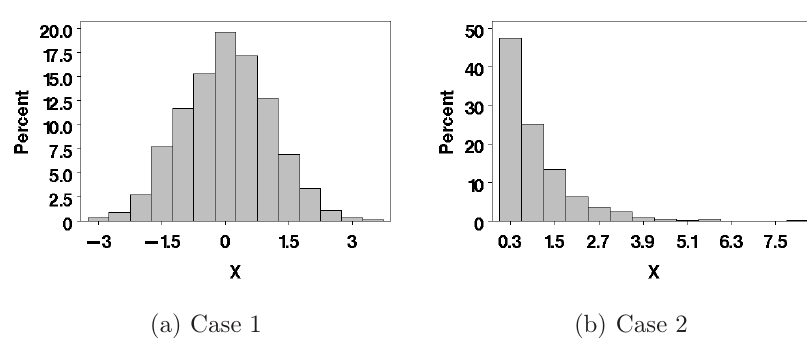
Figure 2. Histograms of finite populations.